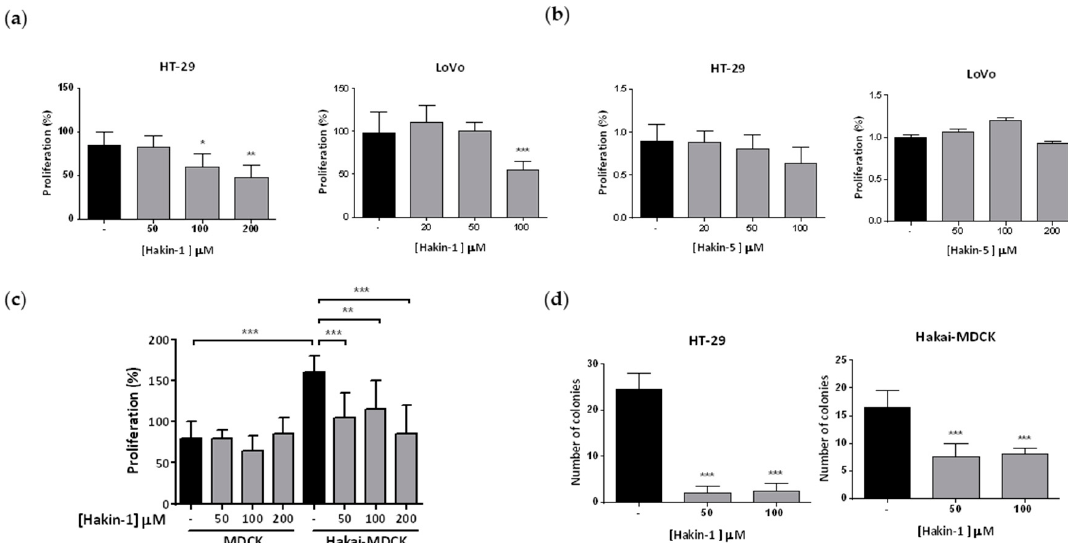
Figure 4. Antiproliferative and antioncogenic e ff ect of Hakin-1 in tumour epithelial cells. ( a ) HT-29 and LoVo cells were treated with Hakin-1 for 48 h and proliferation was measured by performing a BrdU assay as indicated in Material and Methods. Results are expressed as mean ± SD of eight replicates and experiments were repeated three times (* p < 0.05; ** p < 0.01; *** p < 0.001). ( b ) HT-29 and LoVo cells were treated with Hakin-5 for 48 h and proliferation was measured as indicated in ( a ). ( c ) MDCK and Hakai-MDCK cells were treated with increasing concentrations of Hakin-1 for 48h and proliferation was measured as indicated in ( a ). ( d ) Soft agar assay in HT-29 (left panel) and Hakai-MDCK (right panel) cell lines. Colonies grew for 28 days (HT-29) or 21 days (Hakai-MDCK) and were counted as indicated in Materials and Methods. Quantification of the colonies was performed in triplicates and represented as mean ± SD of three independent experiments; (*** p < 0.001).